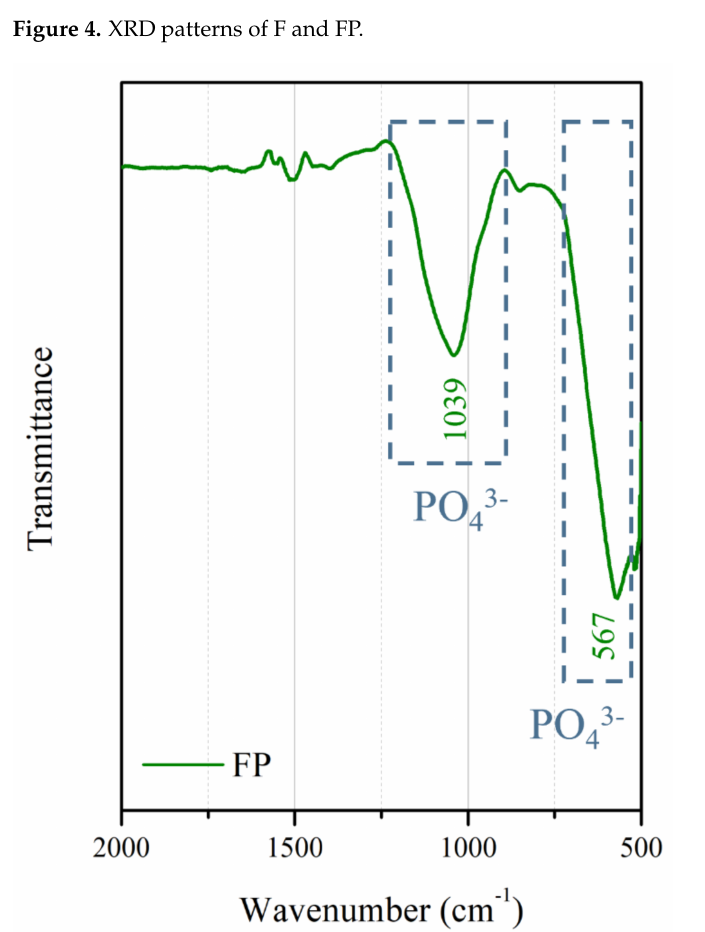
Figure 5. FTIR spectrum of the anodic